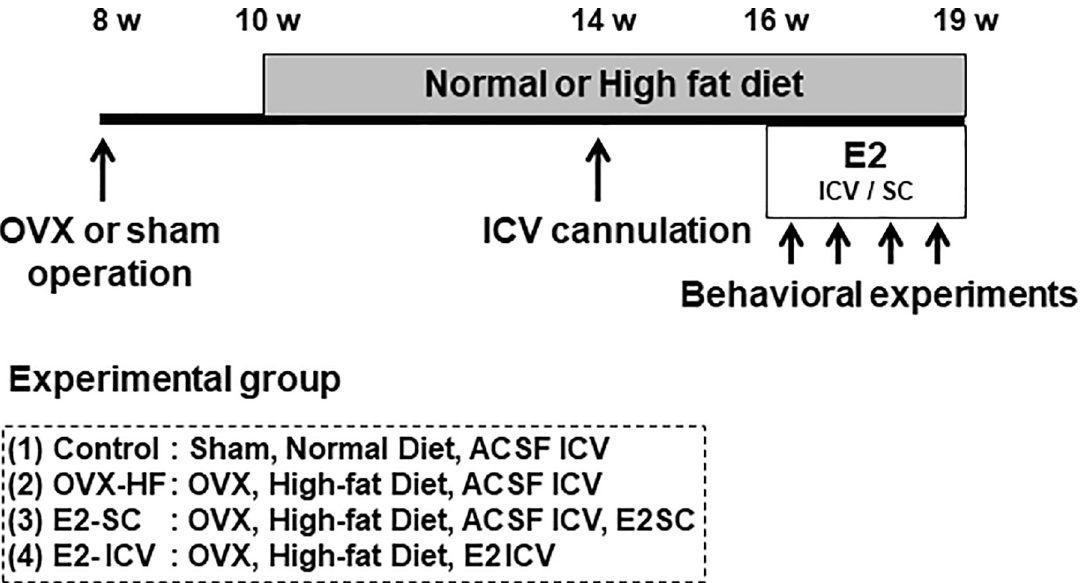
Fig 1. Research protocol. Eight-week-old female C57BL/6J mice maintained for 2 weeks after ovariectomy (OVX) or sham operation were fed a standard diet or a 60% high-fat diet for 4 weeks. At the age of 14 weeks, an intracerebroventriclar (ICV) cannula was implanted, and artificial cerebrospinal fluid (ACSF) was continuously infused into the lateral ventricle by an osmotic pump. At the age of 16 weeks, continuous subcutaneous administration of E2 (50 μ g/kg/day) was conducted in the E2-SC group, or E2 (1 μ g/kg/day) was infused via the ICV cannula in the E2-ICV group. Behavioral tests were conducted during 3 weeks of E2